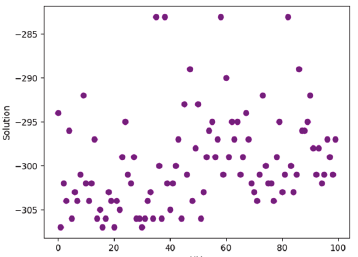
Fig. 7. Diversity of solution vectors in HM after first iteration